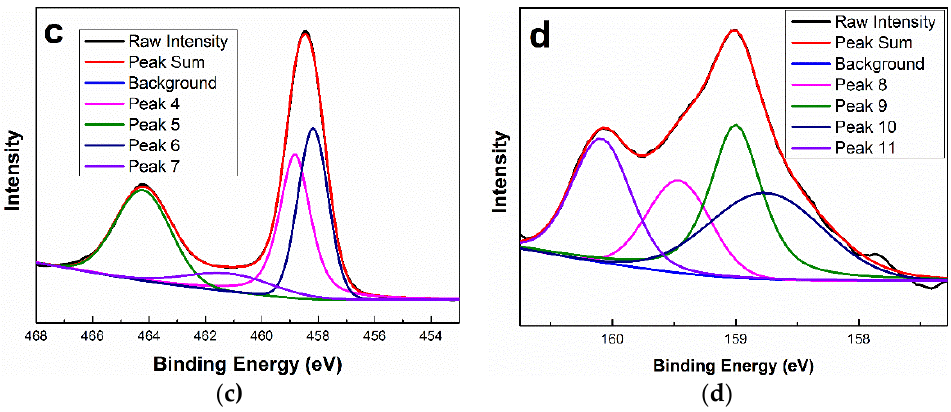
Figure 10. The survey scan and high-resolution X-ray photoelectron spectroscopy (XPS) Spectra of rutile after Bi 3+ ions adsorption ([Bi 3+ ] = 10 −5 mol/L): ( a ) the survey scan spectra; ( b ) curve-fitted O 1s XPS spectra; ( c ) curve-fitted Ti 2p XPS spectra; ( d ) curve-fitted Bi 4f 5/2 XPS spectra. Table 3. The O 1s, Ti 2p, and Bi 4f 5/2 XPS parameters and chemical states for rutile after Bi 3+ ions adsorption. Atom Orbit